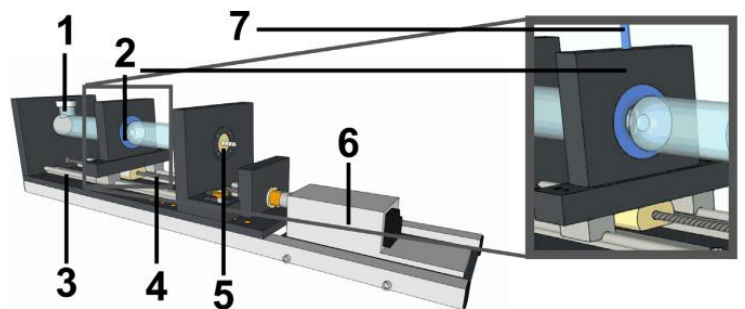
Figure 14. 3D illustration of the mechanical antrum model proposed by Neumann et al. and reprinted from Reference [47] with permission from Elsevier. Explanation of numbers as stated by the authors: